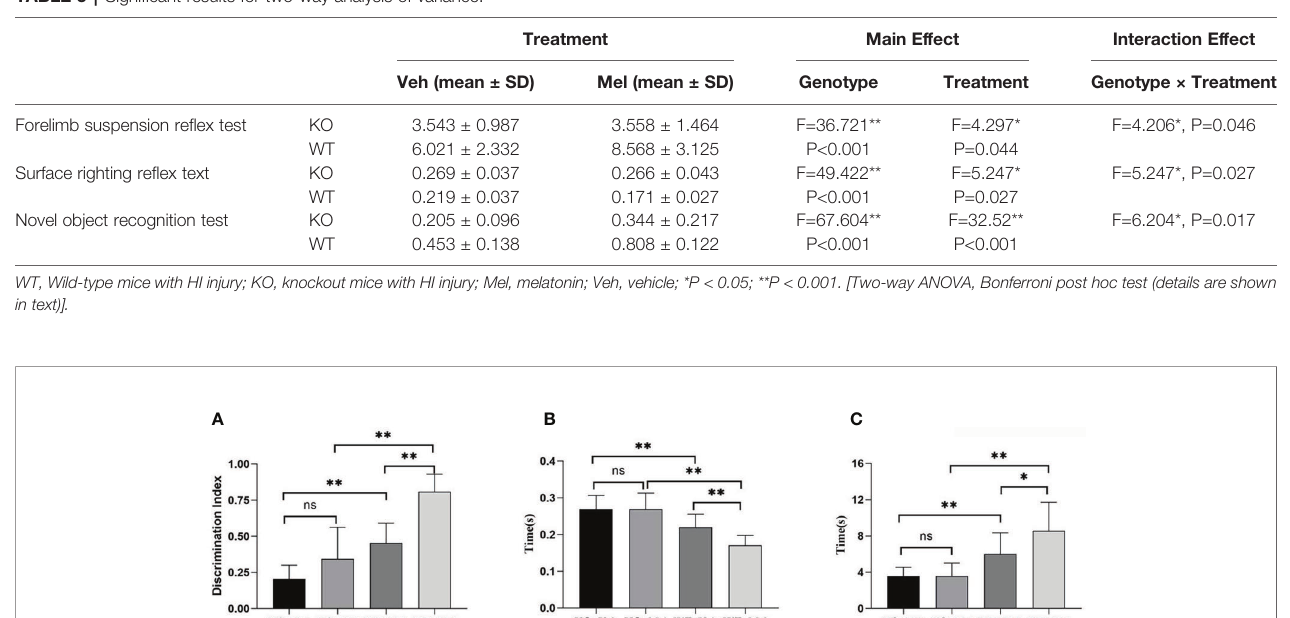
TABLE 3 | Signi fi cant results for two-way analysis of variance.